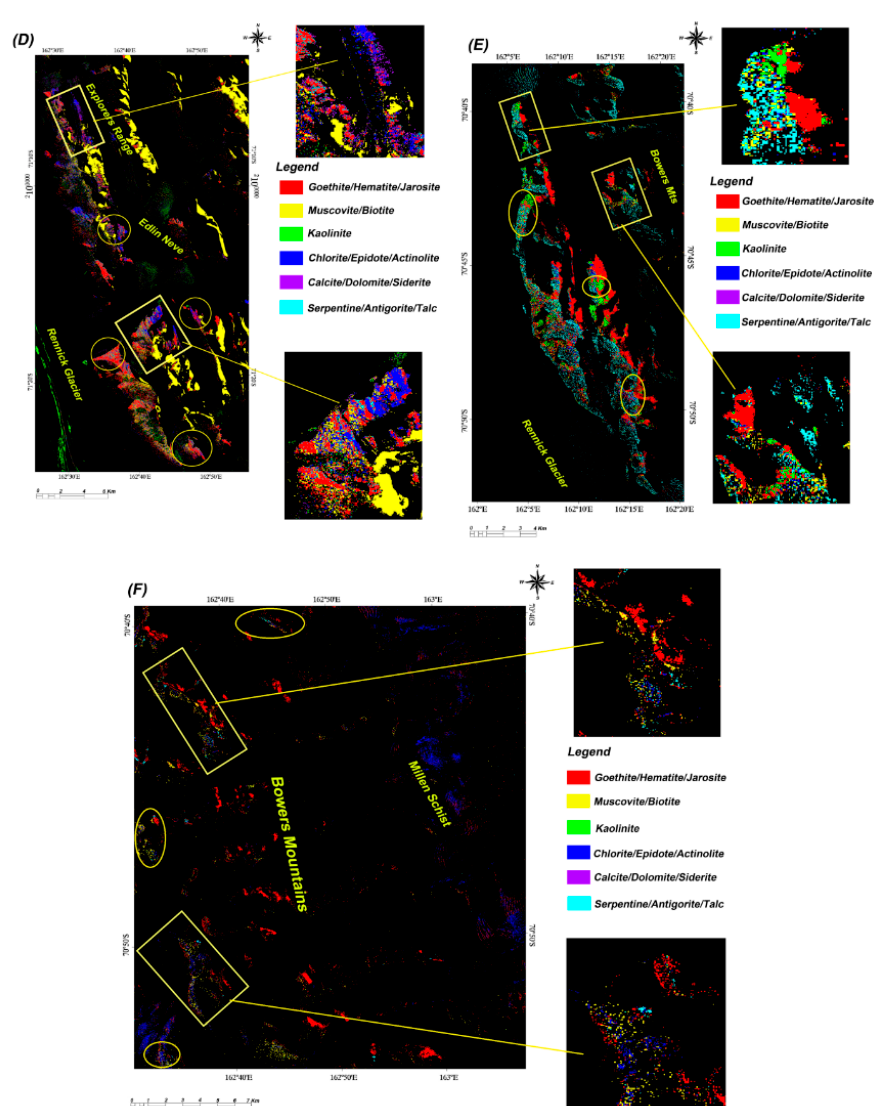
Figure 10. LSU classification mineral maps derived from fraction images of the extracted end-members. ( A ) Zone 1; ( B ) Zone 2; ( C ) Zone 3; ( D ) Zone 4; ( E ) Zone 5; and ( F ) Zone 6. Spectrally dominant mineral groups (concertation more than 10%) are depicted as colored pixels.